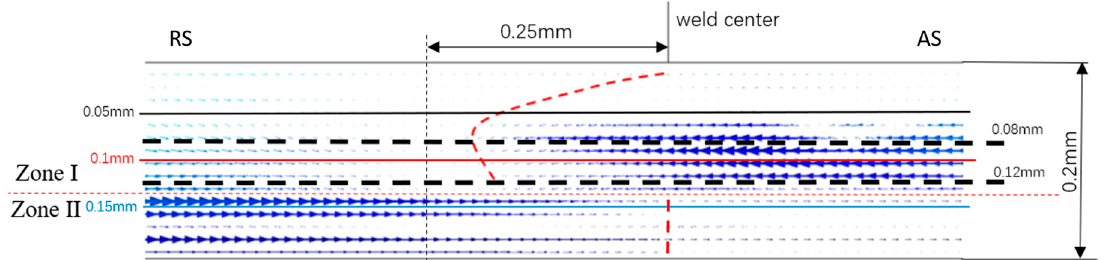
Figure 5. S imulation result of the plastic flow at the root of the weld.